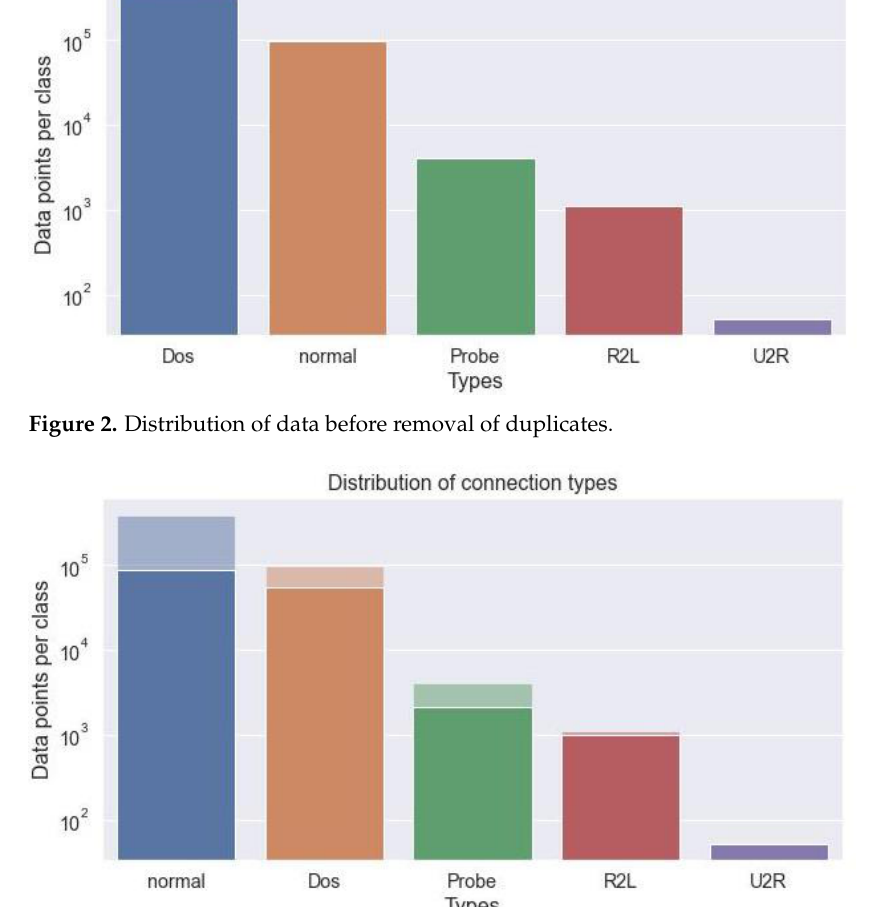
Figure 3. Data distribution after removal of duplicates. The transparent part in each type of connec- tion represents the removed data after